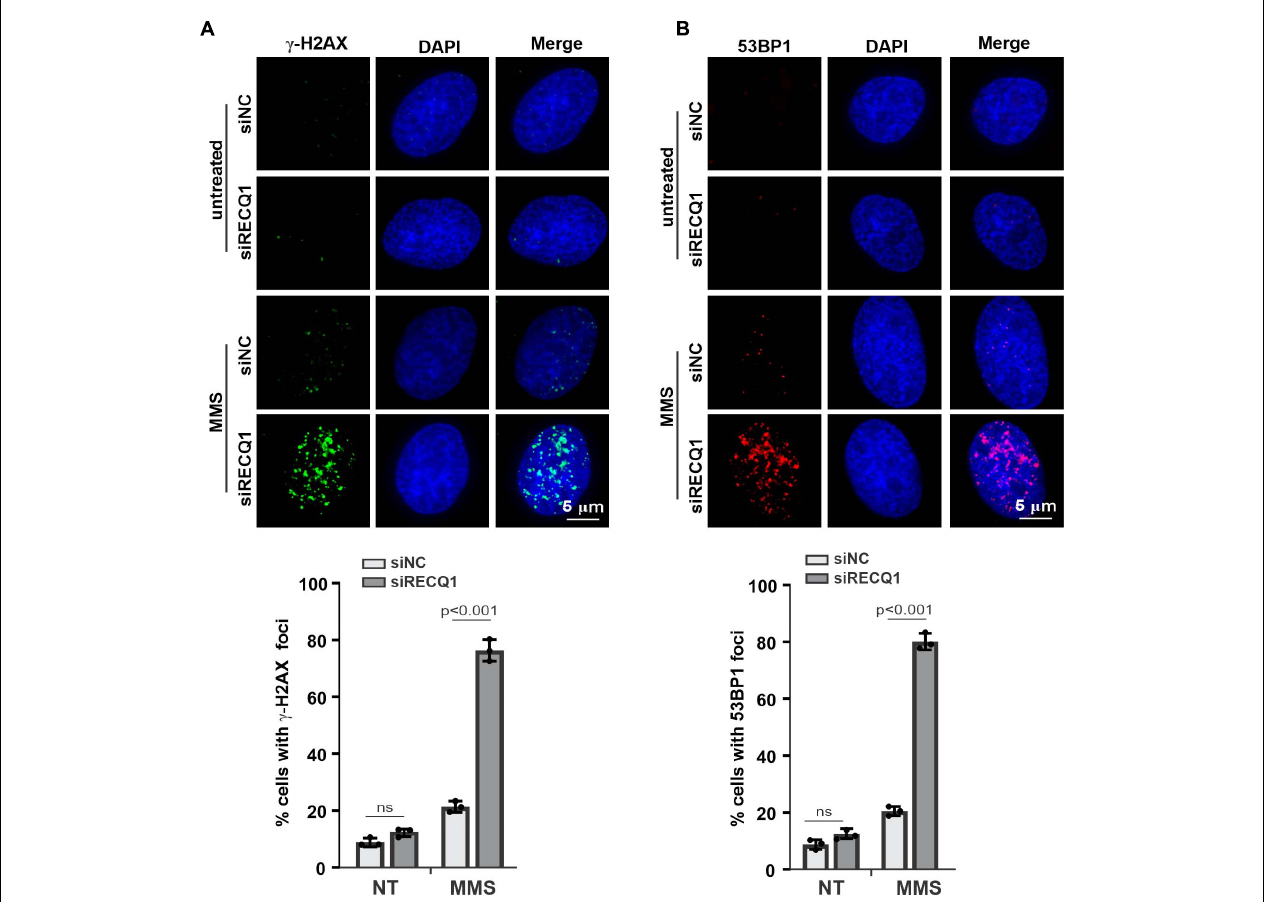
FIGURE 3 | RECQ1 deficiency leads to GBM cells DSB repair defects. (A,B) Treatment of M059K cells with siRECQ1 exposed to MMS resulted in DSBs accumulation, as indicated by nuclear γ -H2AX and 53BP1 staining. Quantification are represented as means ± SD from at least three independent experiments. A two-sided unpaired t -test was used to calculate P -values. Significant: p < 0.05; NS, not significant: P >